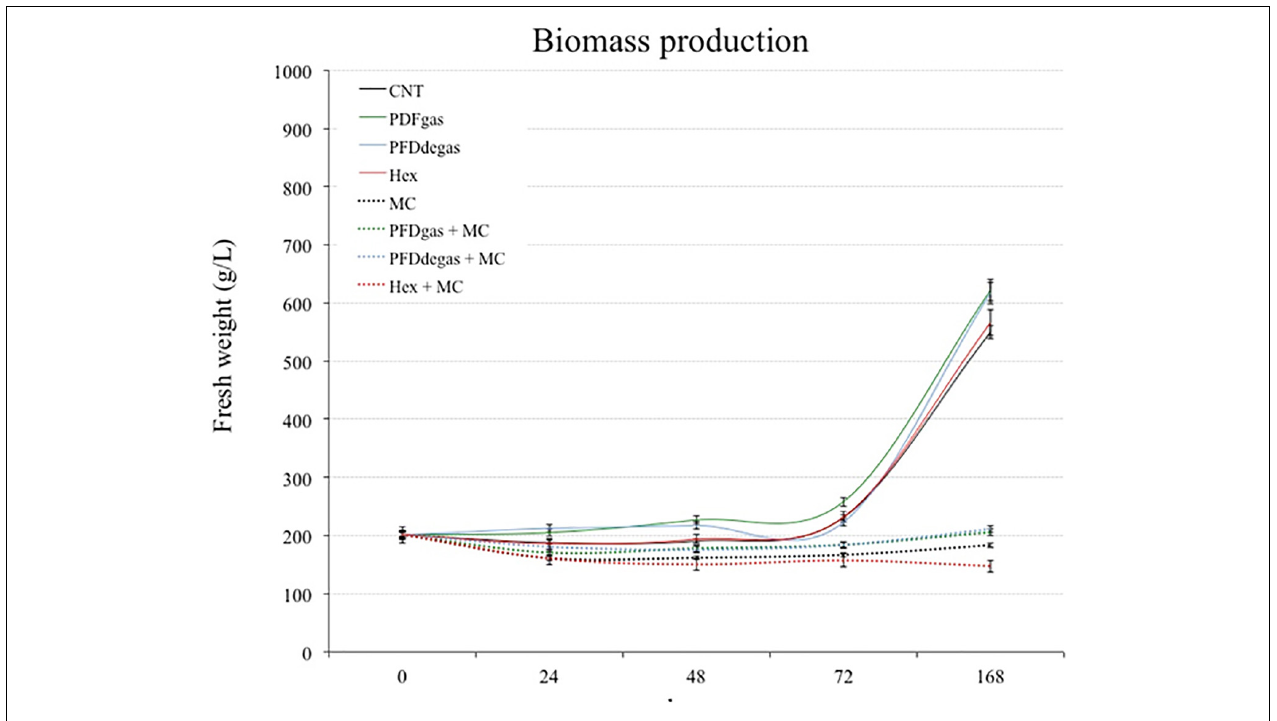
FIGURE 2 | Time course of cell growth in V. vinifera cell cultures measured as g FW/L for 168 h. CNT, culture medium control; PDFgas, gassed perfluorodecalins; PFDdegas, degassed perfluorodecalins; PDFgas + MC, gassed perfluorodecalins plus MeJA and β -CDs; PDFdegas + MC, degassed perfluorodecalins plus MeJA and β -CDs; Hex, Hexenol; Hex + MC, Hexenol + MeJA+ β -CDs; MC, MeJA and β -CDs. Data are the mean of three independent replicates ±